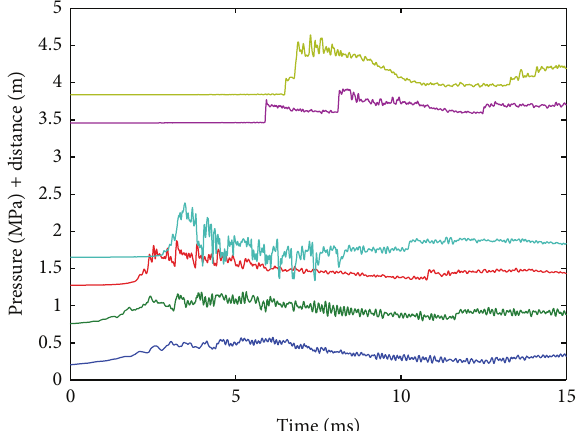
Figure 9: Pressure records from the stoichiometric H 2 S-air mixture (test 28). Channels 1–6 are shown from bottom to top. The pressure levels are offset, an amount equal to the distance (m) from the ignition